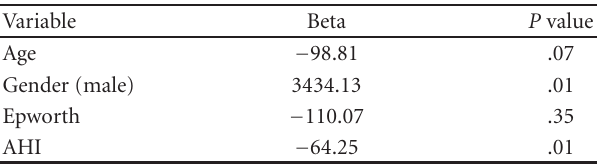
Table 3: Regression results of objective physical activity (meandaily steps